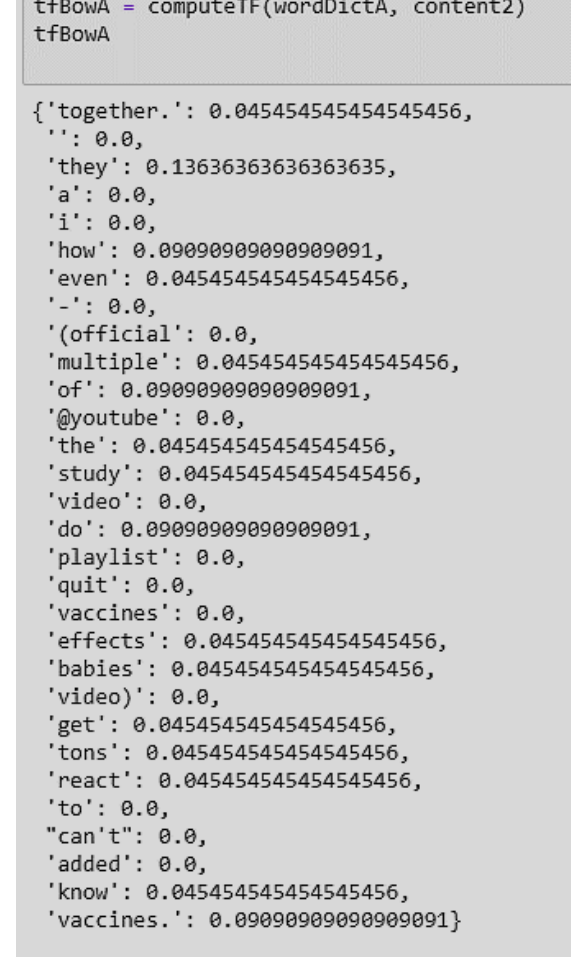
Figure 12. Example of a term frequency score of Document 1 in the dataset.